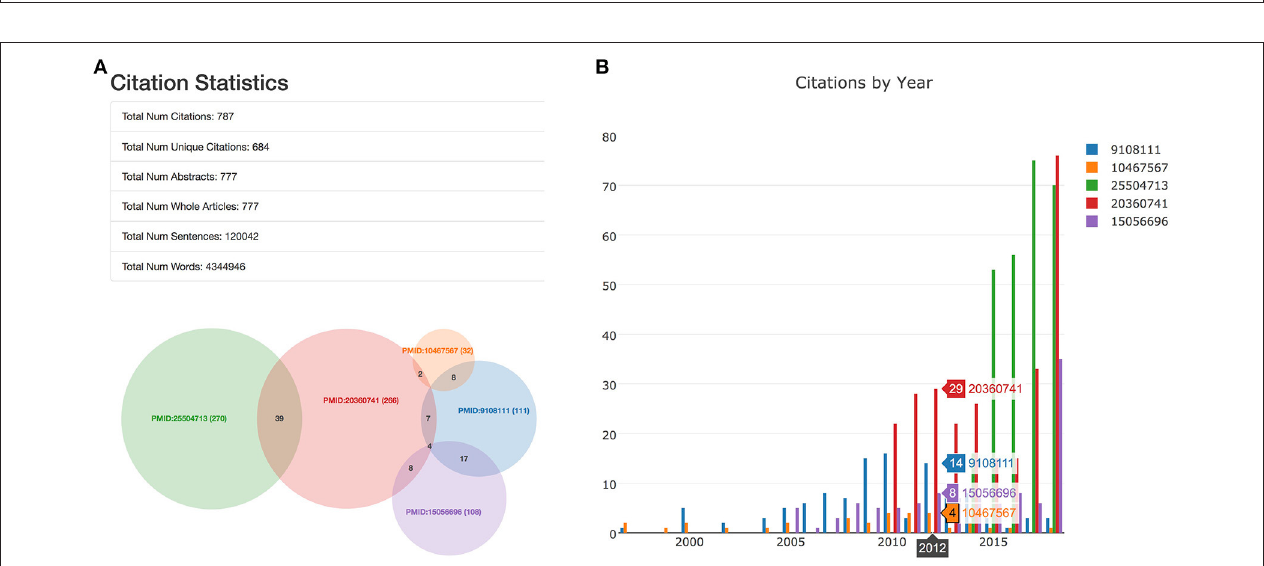
FIGURE 5 | The statistics “tab” includes a table and two visualizations. Here, we highlight this tab for an analysis of five well-cited papers. (A) If multiple papers were entered as input into SCKE, the table and the venn diagram show how many citing papers overlap between them. Details are also provided about the number of abstracts vs. whole articles were used for the analysis, as well as the number of sentences and words. (B) Citations by year are visualized as an interactive histogram. To regenerate this analysis, visit https://tinyurl.com/ybv5e6wo. a 32-core DELL R910 with Intel Xeon X7560 @ 2.27GHz